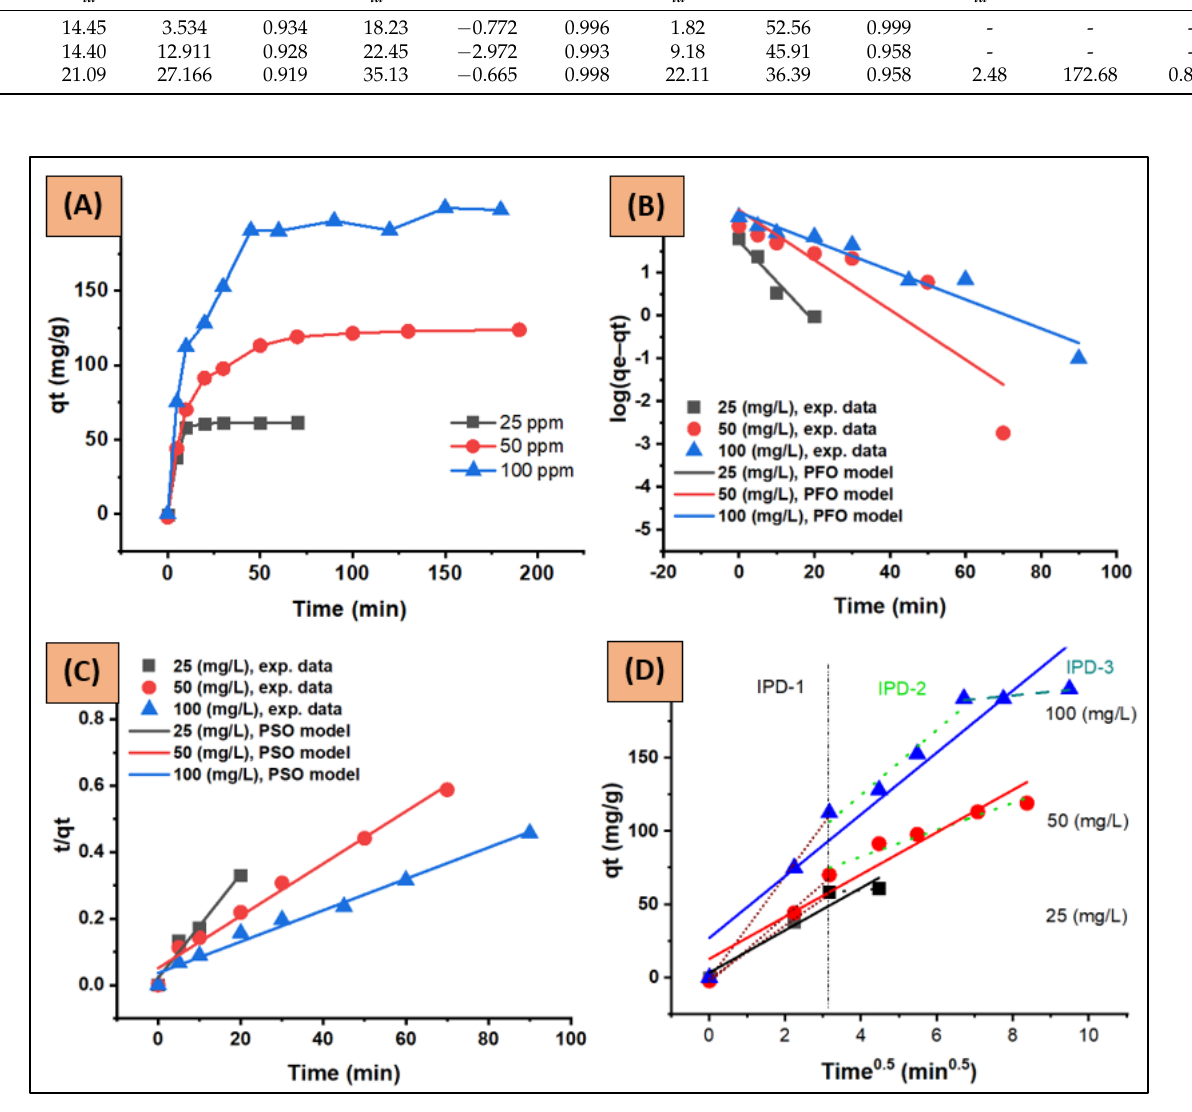
Figure 13. ( A ) Adsorption kinetic profile, ( B ) pseudo-first-order (PFO), ( C ) pseudo-second-order (PSO), and ( D ) intra-particle-diffusion kinetic plots (IPD, IPD stages were marked as IPD-1, IPD-2 and IPD-3) for CV adsorption onto ZFAC. Conditions: adsorbate intial concentration C 0 = 25, 50, and 100 ppm; C 0 volume = 250 mL; adsorbent dose = 0.1 g; tepmerature = 23 °C; pH = 7.2; shaking speed = 150 rpm.